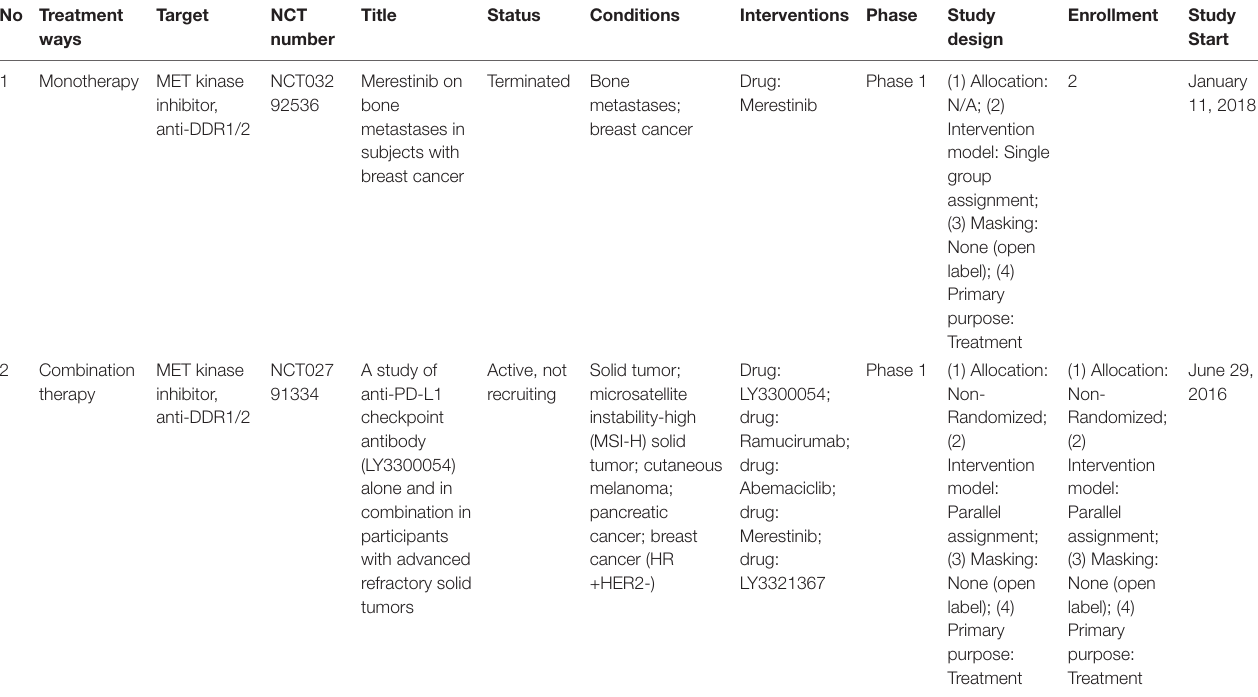
TABLE 1 | Clinical trials of Merestinib targeting breast